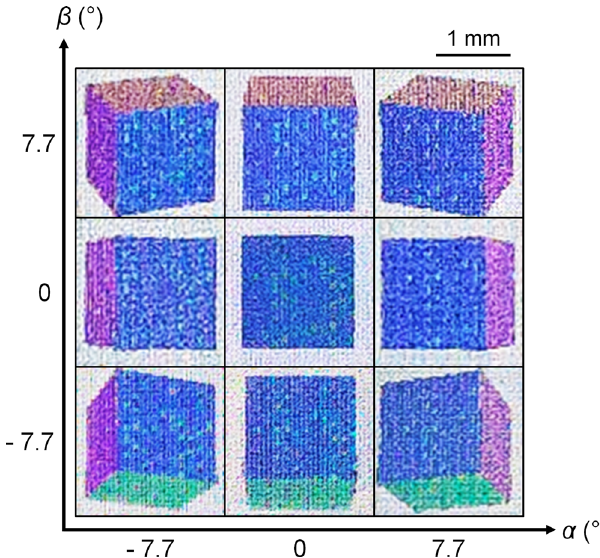
Fig. 4 Light fi eld print encoded with 3 × 3 perspectives of a multi- coloured cube. Digital camera macro images of the cube were captured from each viewpoint denoted by azimuthal angle α and elevation angle β . The cube appeared to protrude out of the plane of the substrate. In this light fi eld print, each colour pixel comprised 5×5 nanopillars (pixel pitch P = 5 µ m). The same scale bar applies to each viewpoint image.